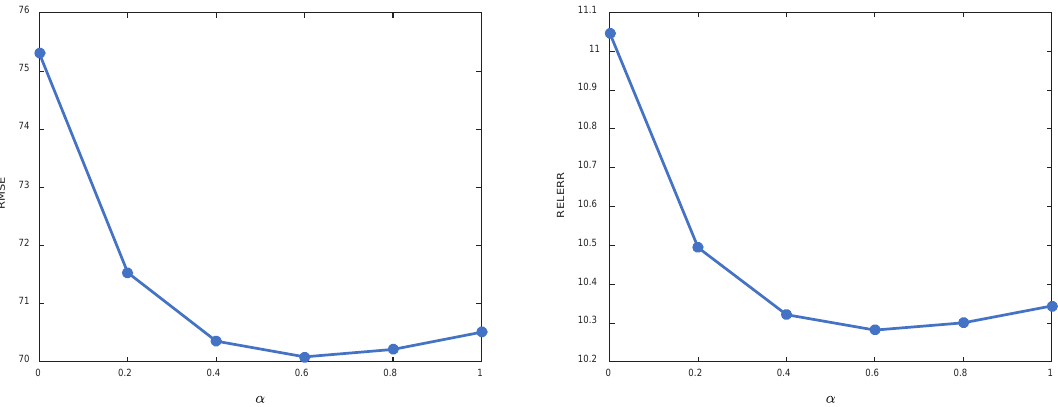
. Figure 7. Performance variation of KSR-EN w.r.t. different values of α 𝐶𝐶